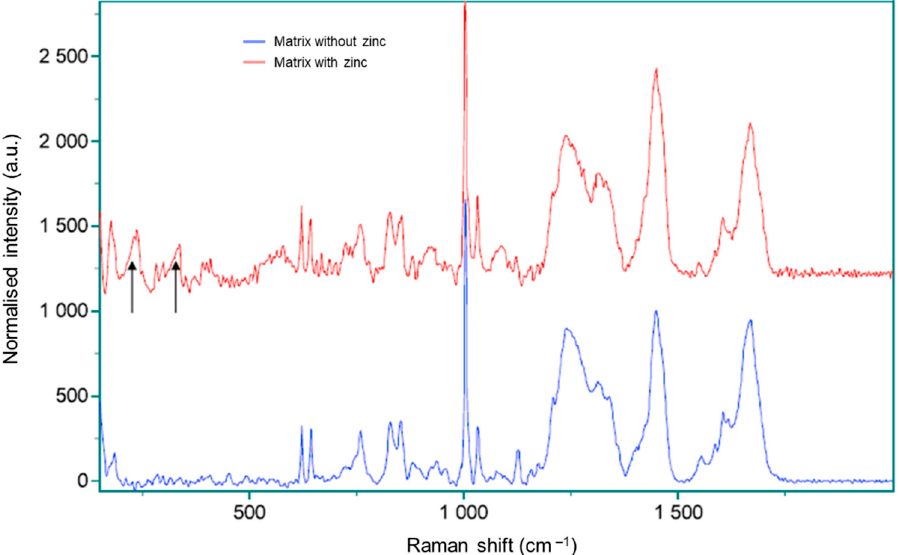
Figure 2. Raman profile of a matrix without zinc and another with zinc incorporated.